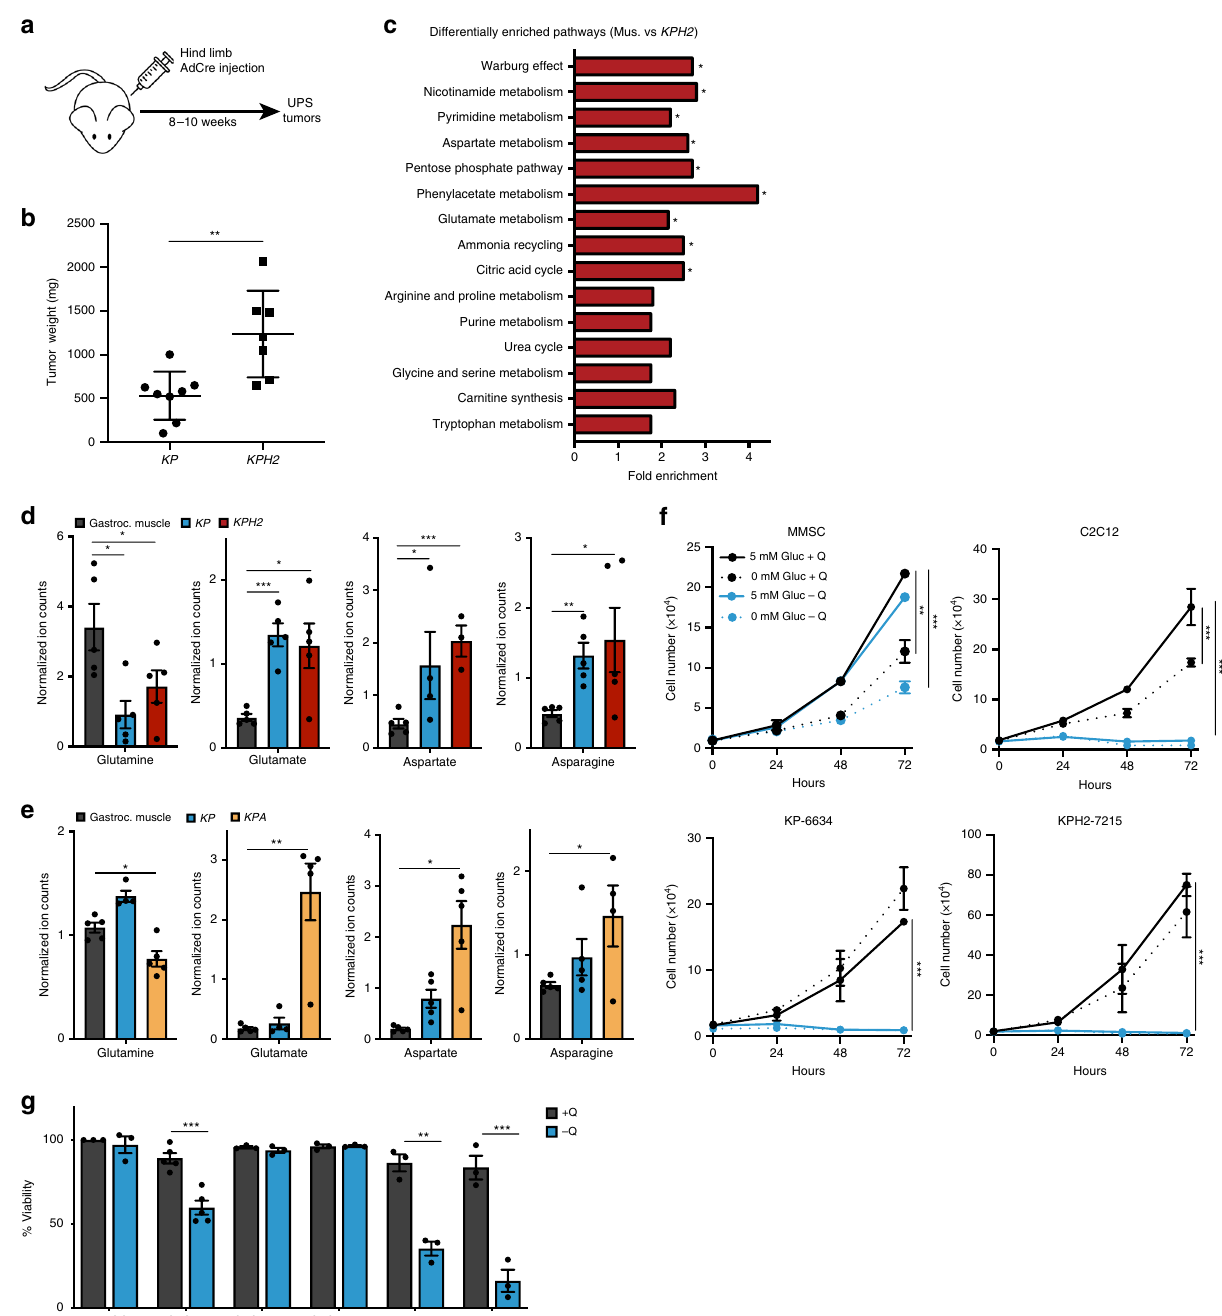
Fig. 1 UPS tumours and cells exhibit evidence of glutamine dependency. a Undifferentiated pleomorphic sarcoma (UPS) tumours are generated by injection of adenovirus expressing Cre-recombinase (AdCre) into hindlimb muscles of LSL-Kras G12D/ + ;Trp53 fl / fl ( KP ) and LSL-Kras G12D/ + ;Trp53 fl / fl ;Epas1 fl / fl ( KPH2 ) mice, and harvested 8 – 10 weeks after viral delivery. b Tumour weights of KP ( n = 8) and KPH2 tumours ( n = 7) at 9 weeks post-AdCre injection. Error bars are ± s.d; ** p < 0.005. c MetaboAnalyst pathway enrichment analysis of VIP > 1 metabolites in muscle (Mus.) and KPH2 comparison following LC/MS; * p < 0.05. N = 4 with three technical replicates. d Normalized ion counts for glutamine, glutamate, aspartate, and asparagine (left to right) in gastrocnemius muscle (gastroc. muscle), KP , and KPH2 tumours. N = 4 with three technical replicates. Data represent mean ± s.d; * p < 0.05, ** p < 0.005, *** p < 0.0005. e Normalized ion counts for glutamine, glutamate, aspartate, and asparagine (left to right) in gastroc. muscle, KP , and LSL-Kras G12D/ + ; Trp53 fl / fl ;Arnt fl / fl ( KPA) tumours. N = 4 with three technical replicates; * p < 0.05, ** p < 0.005. f Proliferation of murine mesenchymal stem cells (MMSC; top left), murine myoblasts (C2C12; top right), KP tumour-derived cells (KP-6634; bottom left), and KPH2 tumour-derived cells (KPH2-7215; bottom right) grown in media with or without glucose (Gluc) and/or glutamine (Q). N = 3 with three technical replicates each. Data represent mean ± s.e.m.; ** p < 0.005, *** p < 0.0005. g Viability of MMSCs, C2C12s, differentiated C2C12s (3 days, C2C12 D3; 6 days, C2C12 D6), KP-6634s, and KPH2-7215s grown in media with or without Q and assessed after 48 h. N = 3 with two technical replicates. Data represent mean ± s.e.m; ** p < 0.005, *** p < 0.0005. p -Values were calculated from a two-tailed Student ’ s t -test for b , d – g . Source data are provided as a Source Data fi